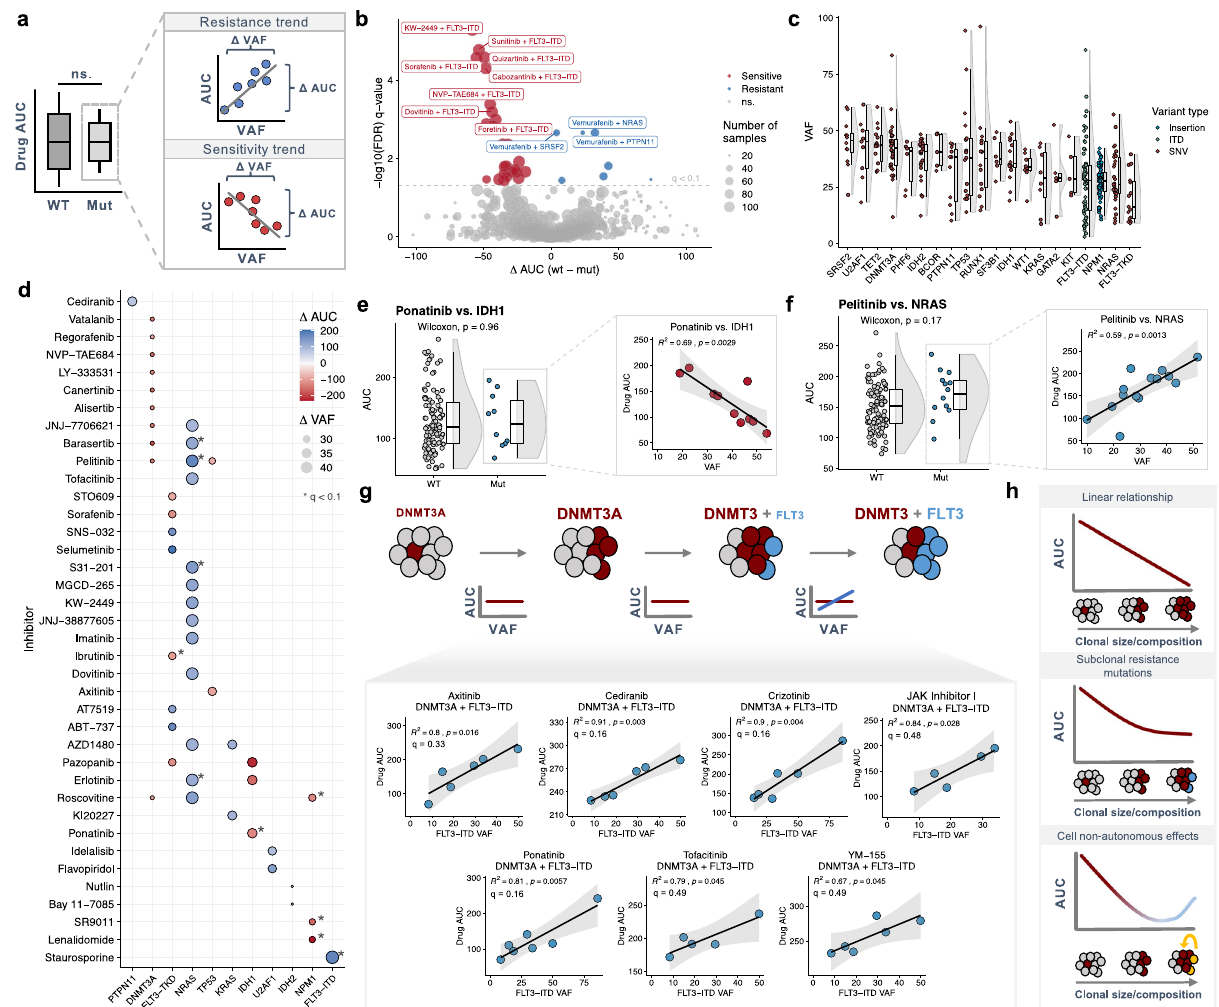
Fig. 6 Clonal abundance predicts drug sensitivity in primary AML samples. a Schematic depicting how linear regression of drug response (AUC) against VAF can identify correlations between drug sensitivity and the clonal prevalence of mutations. Red points represent sensitivity trends while blue points represent resistance trends. b Volcano plot of drug response between mutated and wild-type samples for de novo samples from the Beat AML study. Points are sized based on the number of samples analyzed and colored by signi fi cance (Bonferroni FDR<0.1; red = sensitive, blue = resistant). c Copy number-corrected VAF distribution for mutations with paired drug data in the de novo cohort of the Beat AML study ( n mut + drug ≥ 5; n = 202 biologically independent patient samples). For each distribution, the boxplot represents the boundaries for the fi rst and third quartiles with a line at each median; whiskers delimit the highest data point below the third quartile + 1.5× the interquartile distance and the lowest data point above the fi rst quartile − 1.5× the interquartile distance. d Dotplot of the most signi fi cant ( p <0.05) drug-gene correlations identi fi ed through linear regression of drug AUC against mutation VAF in de novo AML samples. Points are sized based on the range of VAFs for each mutation and are colored based on the type of drug sensitivity trend (red — sensitive; blue — resistant). Asterisks represent drug-gene associations with a Bonferroni FDR<0.1. e , f Representative binary distributions (left) and AUC-VAF scatterplots (right) for clinically relevant sensitivity and resistance VAF correlations for IDH1 ( e ; n WT = 195 samples; n Mut = 10 samples) and NRAS ( f ; n WT = 177 samples; n Mut = 14 samples) , respectively. For each distribution (left), the boxplot represents the boundaries for the fi rst and third quartiles with a line at each median; whiskers delimit the highest data point below the third quartile + 1.5× the interquartile distance and the lowest data point above the fi rst quartile − 1.5× the interquartile distance; p - values are calculated using a two-sided Wilcoxon rank-sum test. For each scatterplot (right), shaded bands represent 95% con fi dence intervals for each linear regression. For each error band, the measure of center is the line of best fi t as derived from linear regression between the drug AUC and VAF for each mutation- drug pair. g Schematic (top) depicting the potential correlation between the subclonal prevalence of a secondary mutation (e.g. FLT3-ITD ) and sensitivity to inhibitors. AUC-VAF scatterplots (bottom) for pairwise genotypes with enough samples ( n ≥ 5; DNMT3A:FLT3 ) where linear regression of drug AUC against VAF revealed strong resistance trends. Shaded bands represent 95% con fi dence intervals for each linear regression. For each error band, the measure of center is the line of best fi t as derived from linear regression between the drug AUC and VAF for each mutation-drug pair. h Schematics representing possible relationships between VAF and drug response. Source data are provided as a Source Data fi